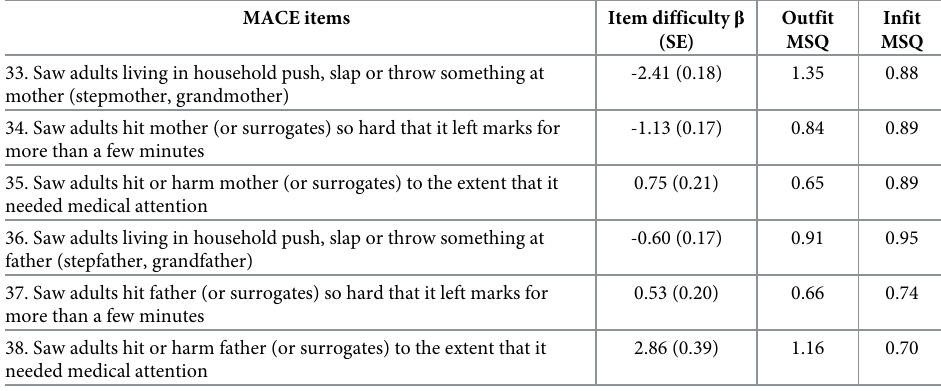
Table 8. Rasch analysis of witnessing interparental violence subscale. MACE items Item difficulty β